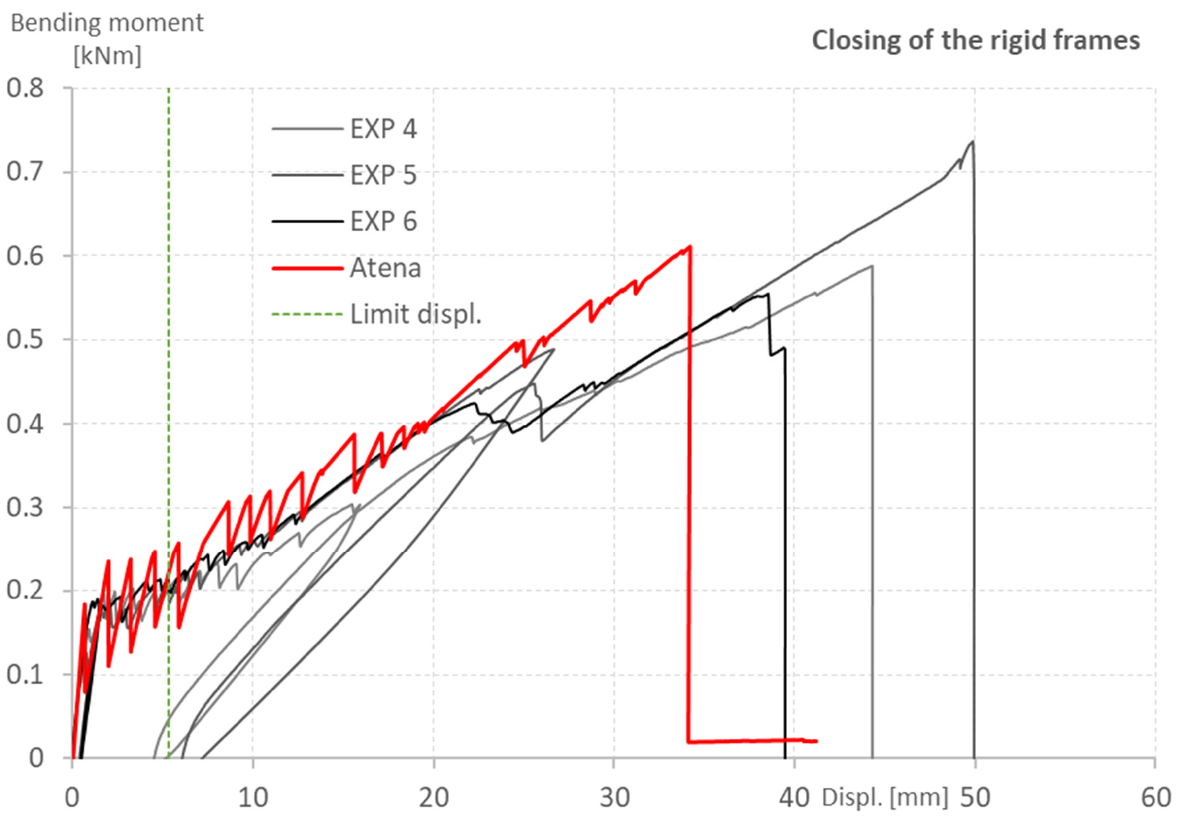
Figure 14. Closing of the rigid frames. Comparison of numerical analysis prediction and experimen- tally tested specimens.